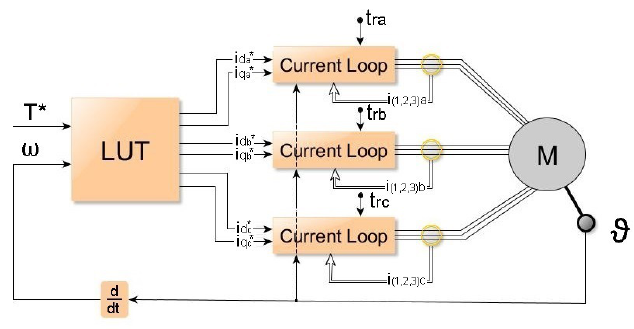
Figure 5. Control block scheme for the triple-3-phase drive.